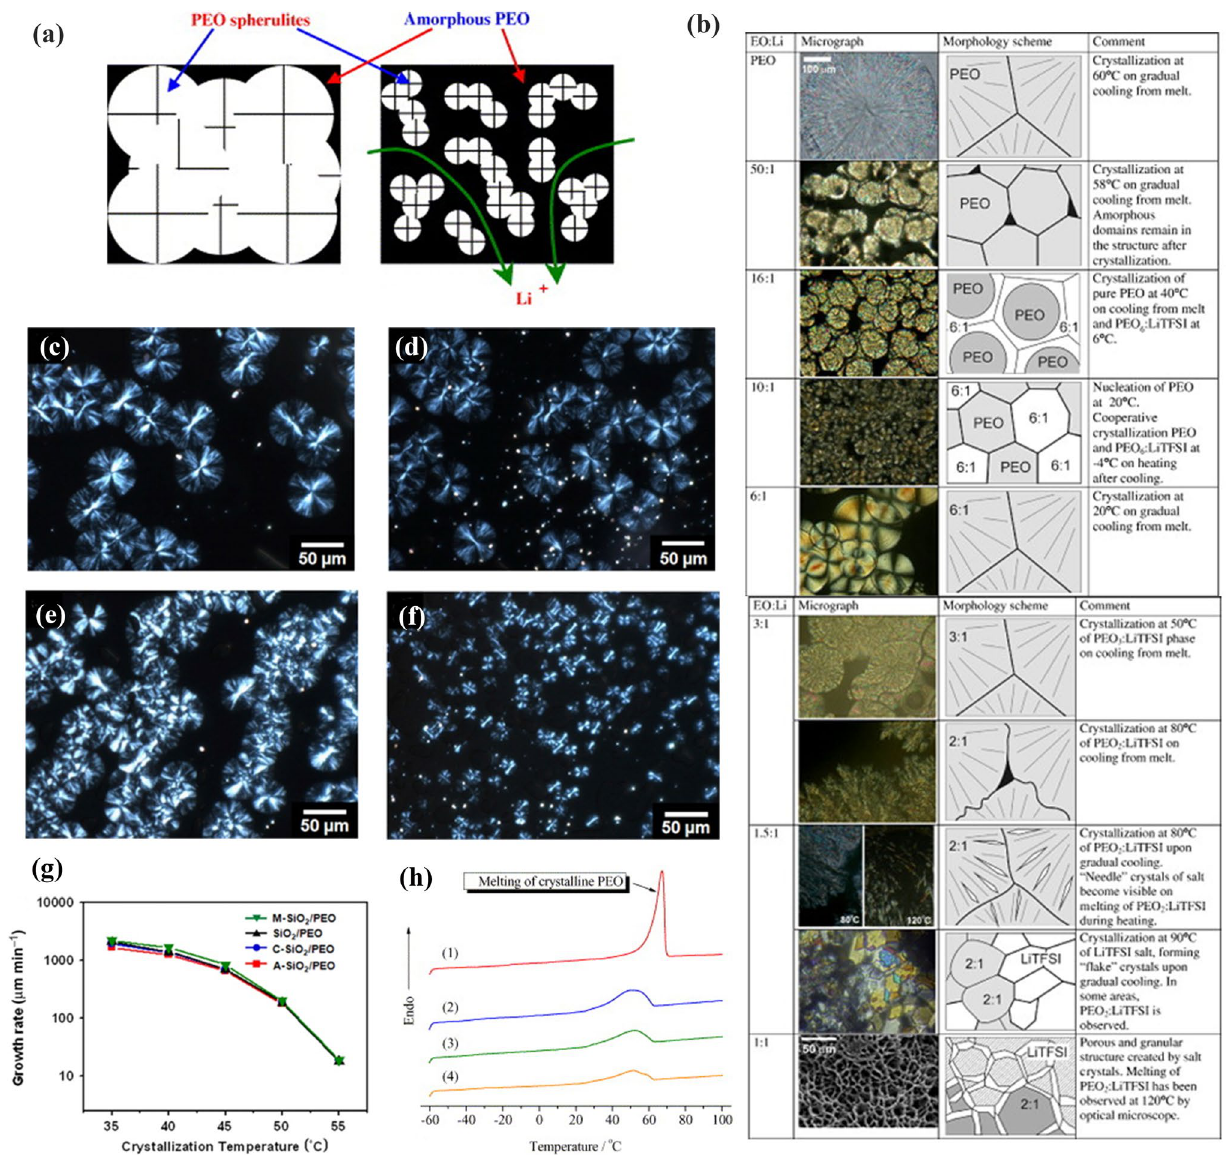
Fig. 13 a Illustration of the transport of lithium ions in PEO spherites. Adapted with permission from Ref. [153]. b The results for PEO/LiTFSI electrolytes of different content salt. Adapted with permission from Ref. [154]. c–f POM pictures of PEO with neat SiO 2 , M–SiO 2 , C-SiO 2 and A-SiO 2 ; g Log plot of the spherites growth rate of SiO2-PEO composites versus the crystallization temperature of as a function of SiO 2 content. Adapted with permission from Ref. [156]. h DSC plots of PEO10-LiClO 4 /10%ZSM-5. Adapted with permission from Ref.